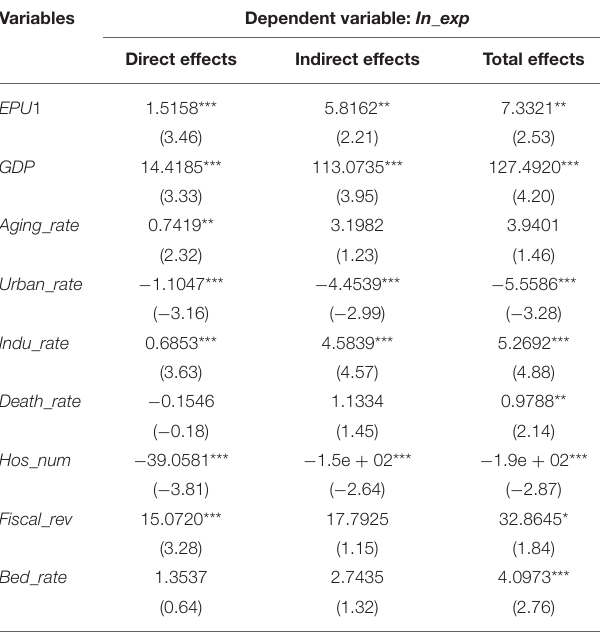
TABLE 6 | Decomposition effects of EPU on healthcare expenditure. TABLE 7 | Estimation results of regional